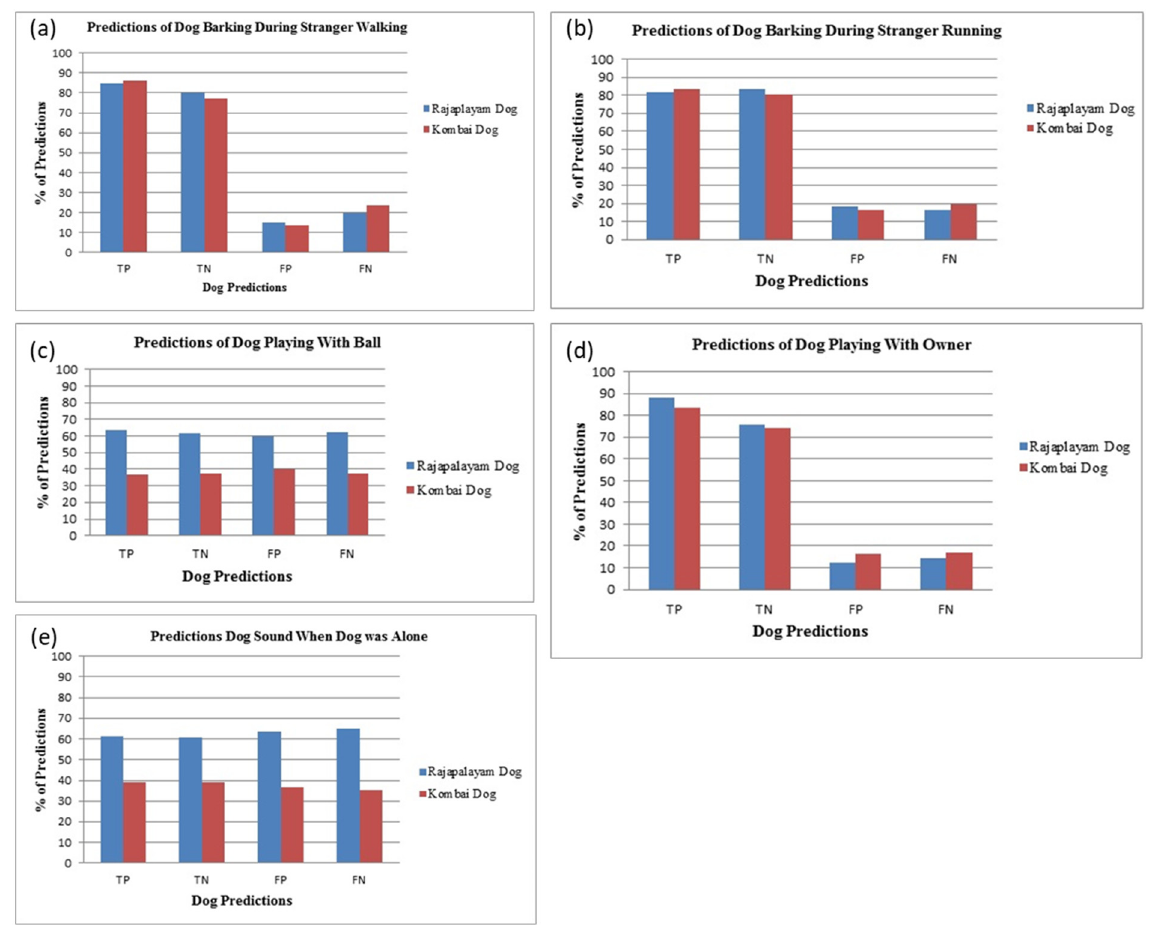
Figure 7. Prediction accuracy of dog sounds during ( a ) stranger walking, ( b ) stranger running, ( c ) playing with a ball, ( d ) playing with owner, ( e ) the dog was alone. ( c ) playing with a ball, ( d ) playing with owner, ( e ) the dog was